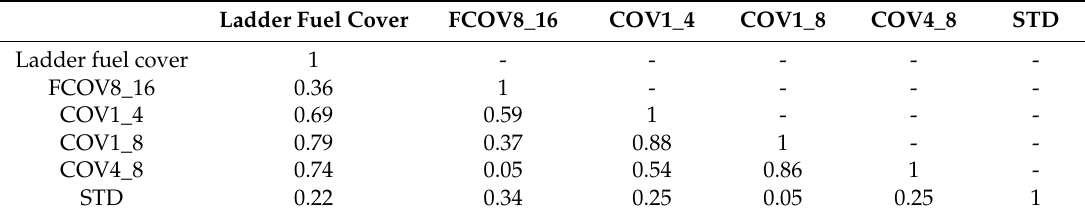
Table 2. Correlation matrix (using Pearson correlation) of variables included in the model, as well as the percentage of all LiDAR returns between 1 and 4 m (COV1_4), and 4 and 8 m (COV4_8). Ladder Fuel Cover FCOV8_16